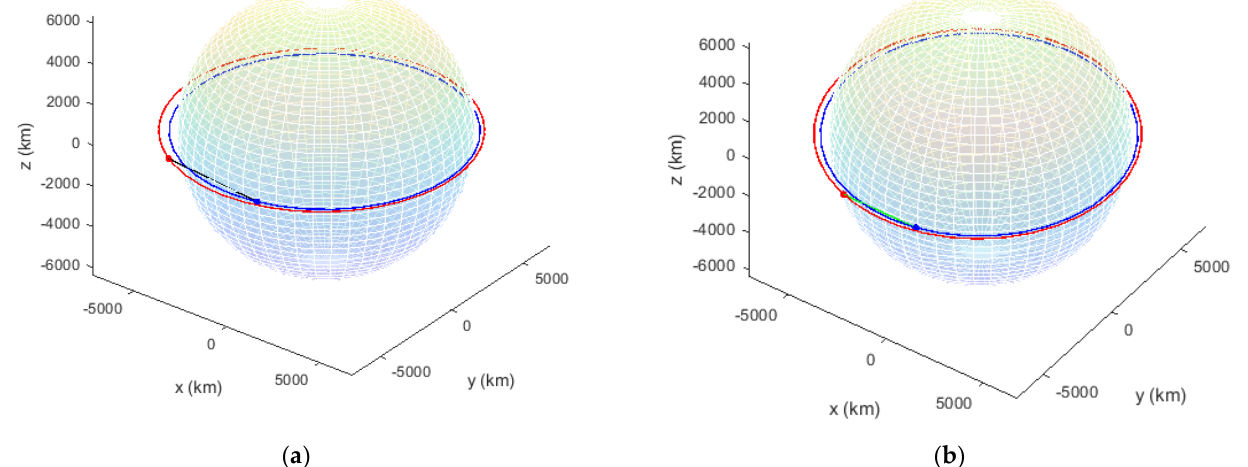
Figure 1. ECI p-N orbits of S and D : ( a ) Case 2, ( b ) Case